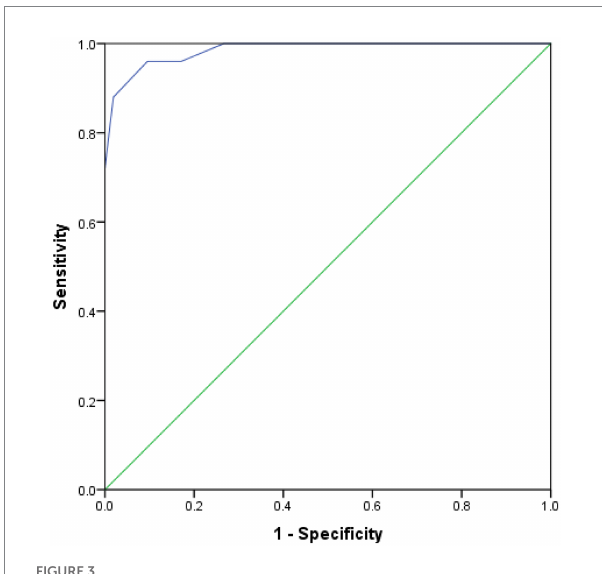
FIGURE 3 ROC curve for the diagnosis of sum on OSA.